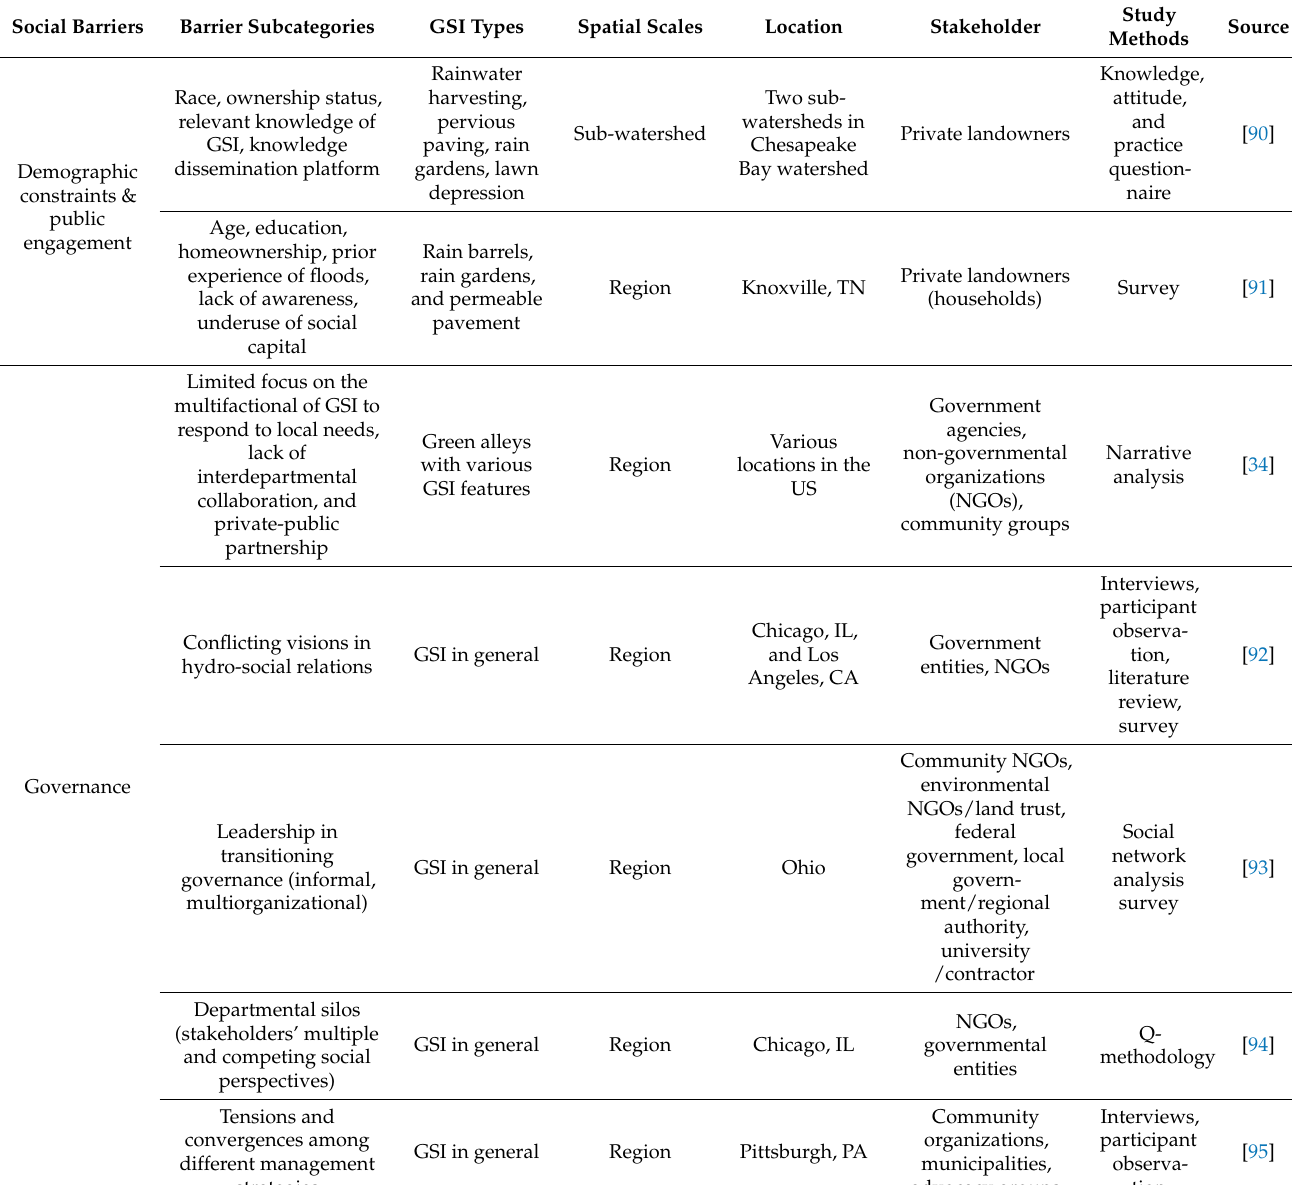
Table 1. Relevant social factors that could influence the implementation of GSI in the